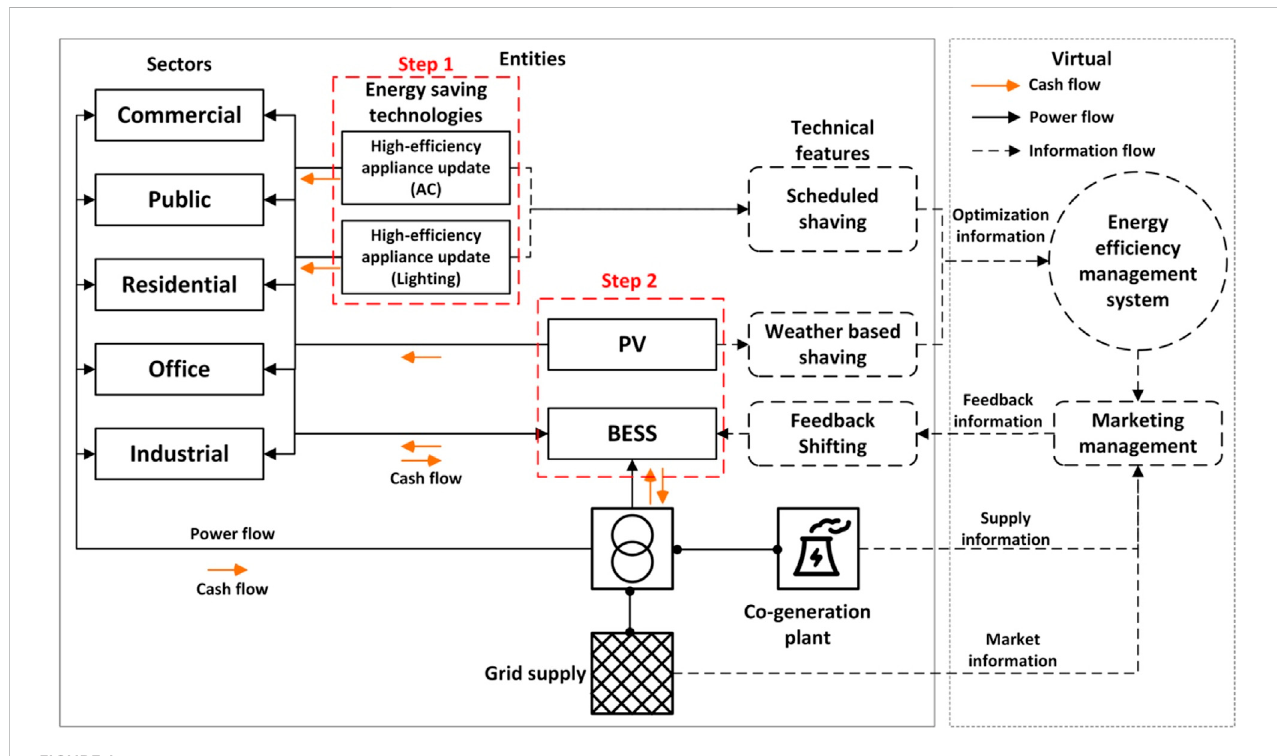
FIGURE 1 System description of the proposed VPP